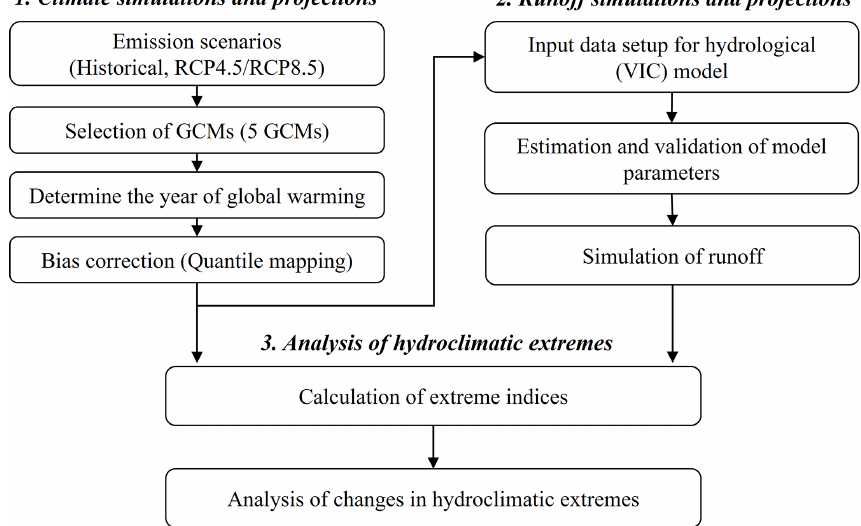
Figure 2. Flowchart of the entire procedure used in this